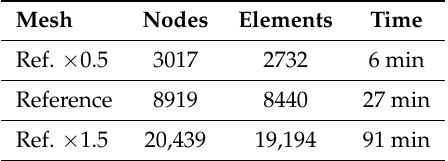
Table 2. Mesh sizes and computing